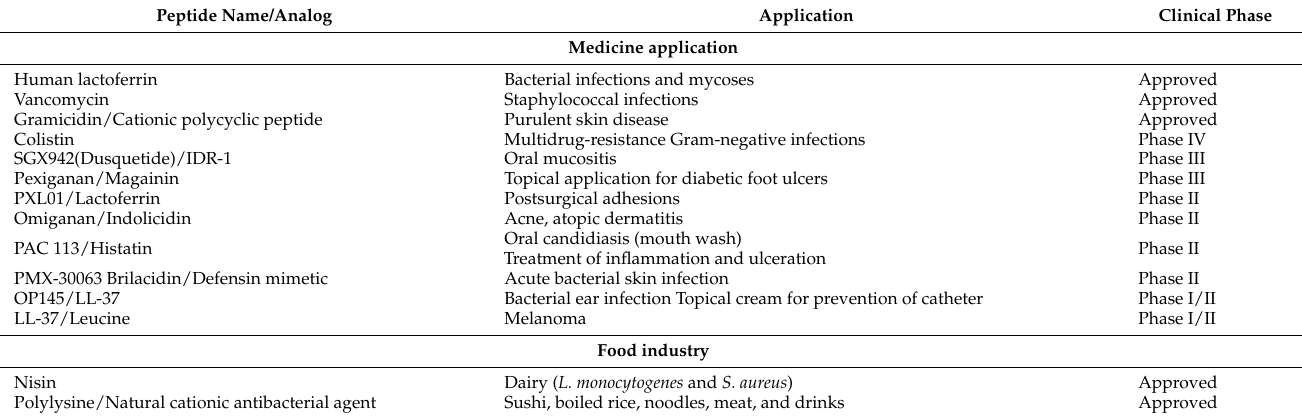
Table 4. AMPs in the clinical phase of